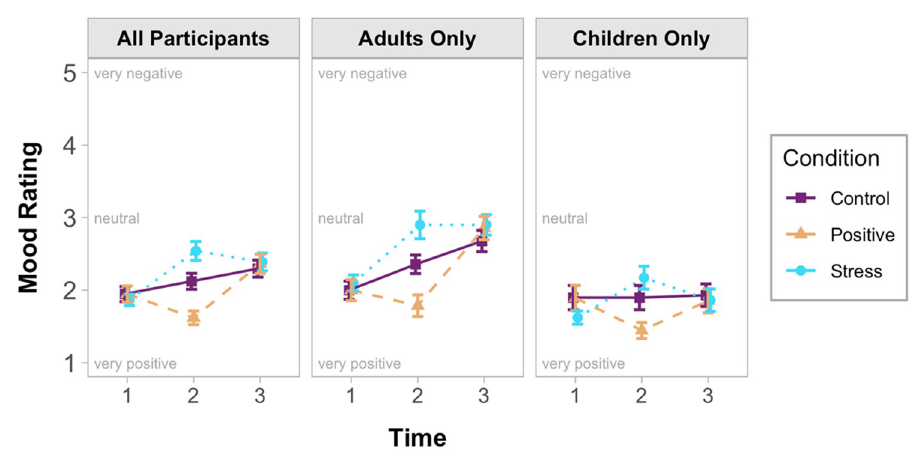
Fig 1. Participant self-reported mood ratings separated by condition, time, and participant age.